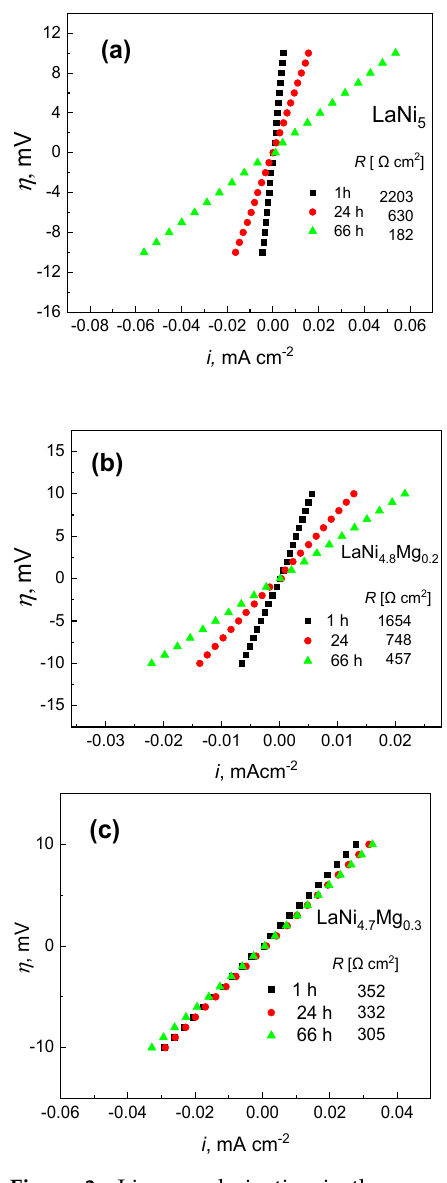
Figure 3. Linear polarization in the range of E OCP ± 10 mV for the studied alloys: LaNi 5 ( a ); LaNi 4.8 Mg 0.2 ( b ); LaNi 4.7 Mg 0.3 ( c ). The changes in the polarization resistance value as a function of time, and thus the corrosion rate, were most pronounced for the starting LaNi 5 . After a short one-hour exposure time in solution, the LaNi 5 electrode showed the highest polarization resistance value, and therefore the lowest corrosion rate (0.033 mA cm − 2 ) compared to the magnesium-substituted alloys (Figure 4). Nonetheless, upon prolonged contact with the electrolyte, the corrosion resistance of LaNi 5 dropped sharply, and after 66 h the corrosion rate increased to 0.91 mA cm − 2 . For a short exposure time of 1 h, the substitution of a part of the nickel with magnesium resulted in a decrease in the polarization resistance, and thus an increase in the corrosion rate, which was especially pronounced for the high- magnesium alloy. However, as can be seen in Figure 4, the corrosion rate for this material did not change significantly over the examined period of time (66 h), and ranged from 0.47 to 0.54 mA cm − 2 . Thus, the longer the contact of the electrolyte with the studied material, the more advantageous the presence of magnesium in the La(Ni, Mg) 5 alloys became from the point of view of corrosion resistance, especially for the high-magnesium alloy. exposure time, h Figure 4. Corrosion rate dependence on exposure time in 6M KOH solution for LaNi 5-x Mg x alloys (x = 0, 0.2, and 0.3).